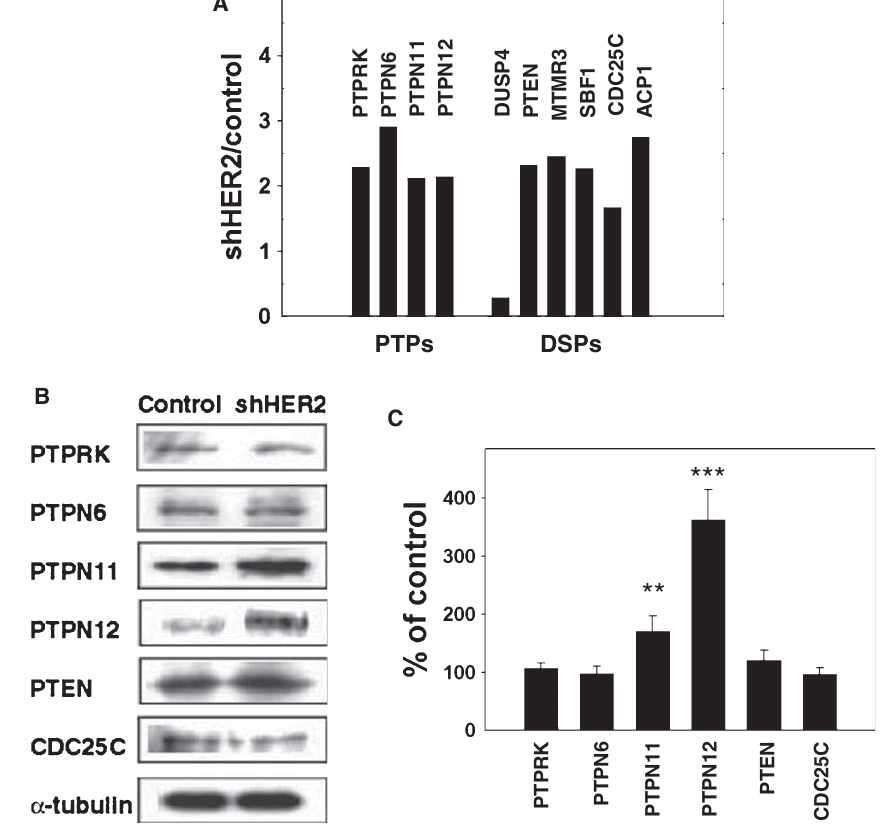
Fig. 2. Tyrosine phosphatases (PTPs) and Dual-Specificity phosphatases (DSPs) in HER2-silenced SKOV-3 cells. (A) RNA fold-change. Total RNA was purified from HER2-silenced and control cells (carrying the empty vector) and used to generate labeled antisense RNA for subsequent DNA microarray hybridization. The results are given as expression rates of shHER2/control cells. Average of 3 experiments, performed with RNA derived from independent purifications. (B) Protein immunoblots. Extracts were prepared from cells as in A and used to immunodetect the indicated PTPs and DSPs and (cid:2) -tubulin. (C) Immunoblot quantification. Protein bands as in B were quantified by densitometric scanning and normalized to (cid:2) -tubulin, detected on the same membrane. Results are given as percent of normalized bands from control cells (i.e., 100 values are equal to control values). Average ± SEM of 3–4 independent experiments. Statistical analysis (Student’s t test): ∗∗ p <0.01; ∗∗∗ p